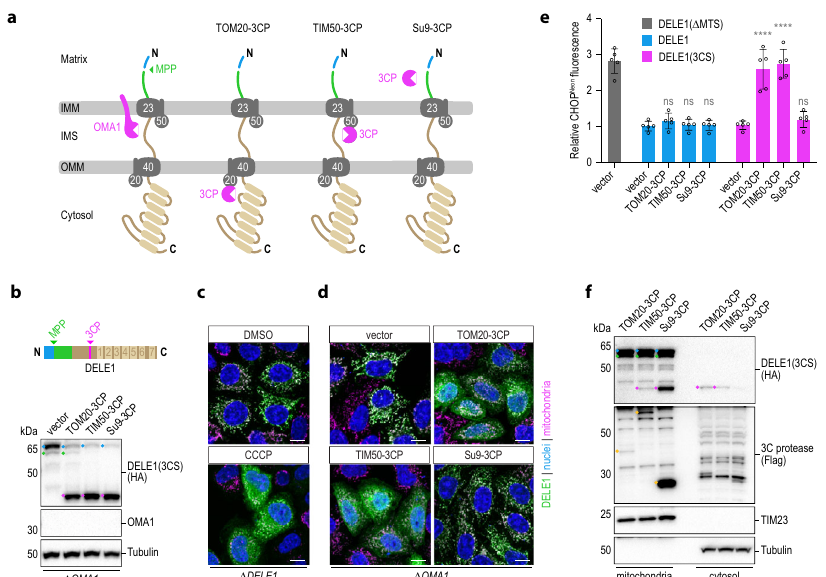
Fig. 4 Cleavage of DELE1 in the IMS is suf fi cient for its release to the cytosol and activation of the ISR. a Schematic depicting the localization of the proteases employed in this fi gure relative to the DELE1 protein during its import into mitochondria. b HeLa OMA1 knockout ( Δ OMA1 ) cells were transiently transfected with DELE1(3CS) and empty vector control or the indicated 3C protease fused to TOM20, TIM50 or the sorting signal of Su9. Cleavage of the DELE1 protein was analyzed by immunoblotting. c , d HeLa cells were transiently transfected with DELE1(3CS) as in ( b ). Localization of the DELE1 protein was analyzed by confocal microscopy after a 2 h treatment with DMSO or CCCP ( c ) or in the context of the co-transfected 3C proteases ( d ). Scale bars, 10 μ m. Nuclei (DAPI, blue), mitochondria (MitoTrackerRed, pink), DELE1 (HA, green). e The induction of the ISR marker CHOP was measured in HAP1 CHOP Neon OMA1 knockout cells by fl ow cytometry upon transient transfection of the indicated constructs together with mCherry. Relative CHOP Neon fl uorescence to empty vector transfected cells is shown. Graph depicts mean ± s.d. of n = 5 independent experiments. DELE1( Δ MTS) was used as positive control. Statistical signi fi cance within DELE1 constructs compared to the respective vector control was assessed by ordinary one-way ANOVA and Dunnett ’ s multiple comparisons correction. DELE1: ns ≥ 0.4019; DELE1(3CS): **** P < 0.0001, ns = 0.8269. f HeLa DELE1 3CS-HA cells were transfected with the indicated Flag-tagged 3C protease (yellow dots) and cleavage and localization of DELE1 species in mitochondria or the cytosol was analyzed upon subcellular fractionation by